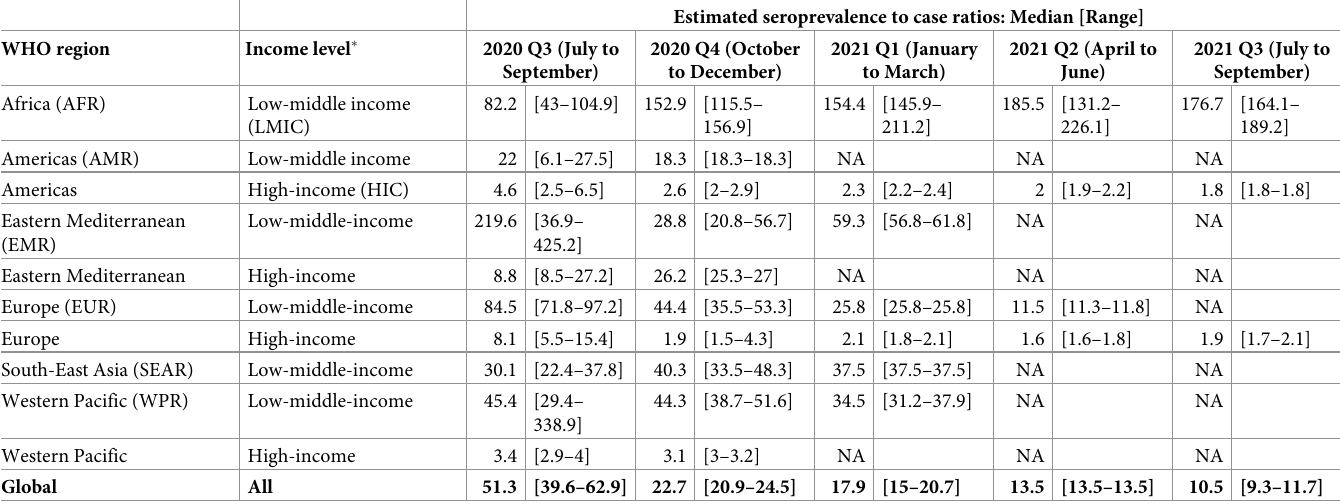
Table 2. Median estimated seroprevalence to cumulative incidence ratios by WHO region, World Bank income level, and quarter using national studies. Estimated seroprevalence to case ratios: Median